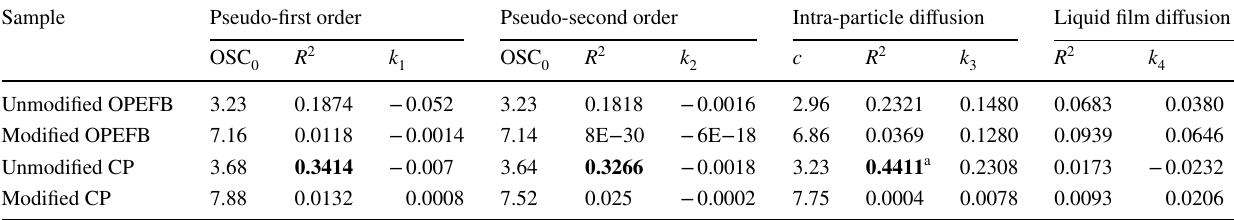
a means the highest R 2 values Moderate R 2 values are